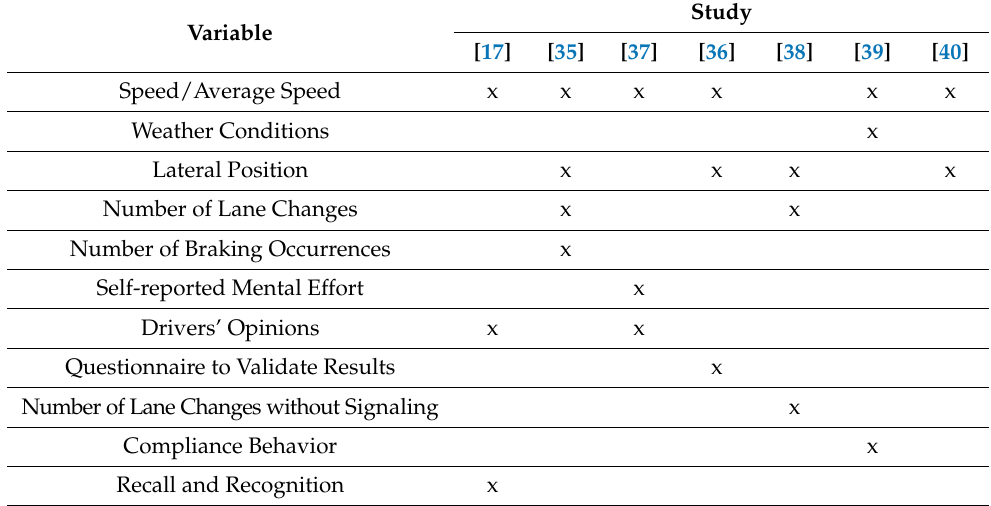
Table 3. Variables used in previous